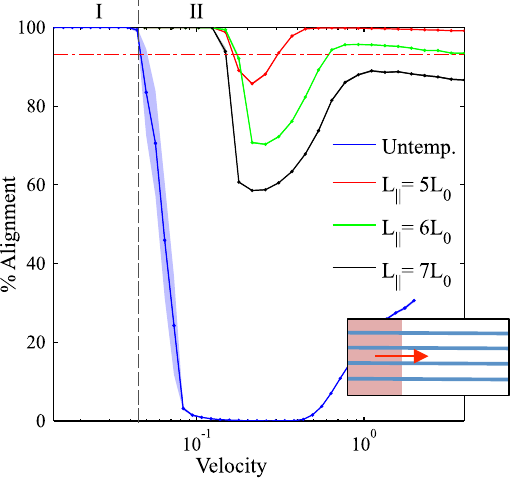
Figure 12. The percent alignment to within ± 30 degrees of the direction parallel to the zone velocity for samples with parallel (horizontal) template stripes. The zone width is w zone = 80 ˜ l . A shift in the transition velocity from Regions I to II is observed due to the presence of the template stripes. For comparison, the horizontal line shows average alignment of isothermally annealed samples with templating at L || = 5 L 0 with annealing times equivalent to lowest velocity annealing times. Inset: template alignment (blue) is parallel to zone velocity (red).